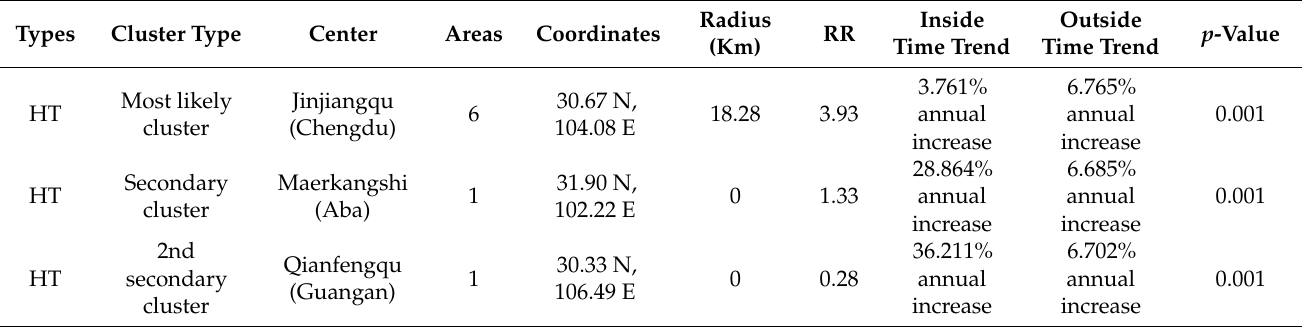
Figure 7. Higher spatial variation in temporal trends. HT, health technician; LD, licensed doctor; RN, registered nurse; PH, pharmacist; TE, technologist; IN, intern. Table 2. The space–time results of all types of healthcare professionals.